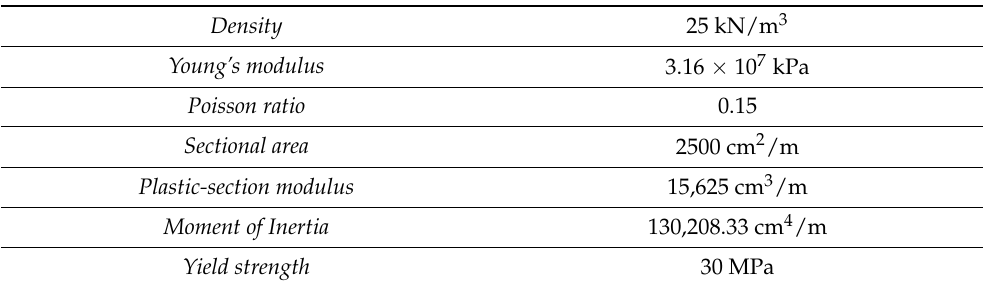
Table 2. Properties of concrete lining.